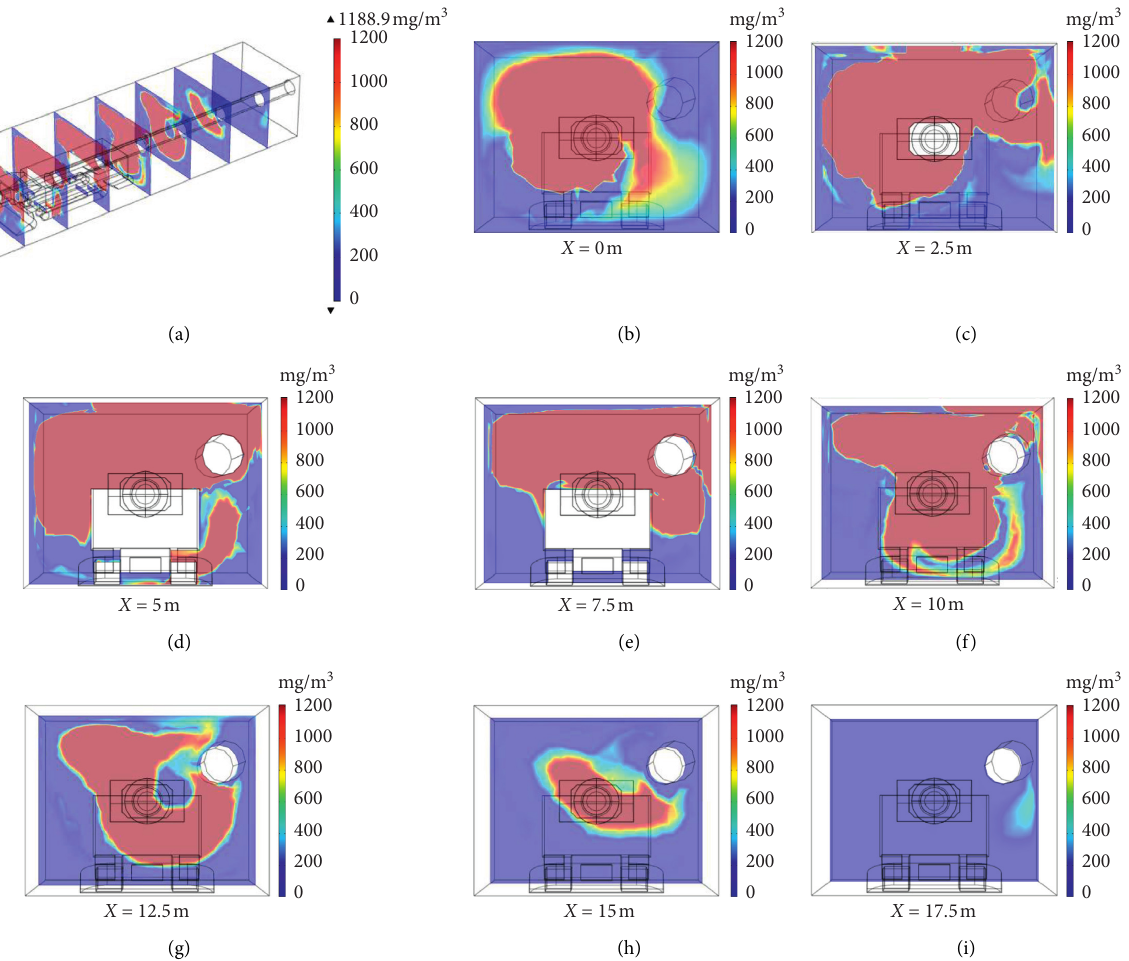
Figure 4: Simulation of dust concentration field in different cross sections in the x -axis direction.